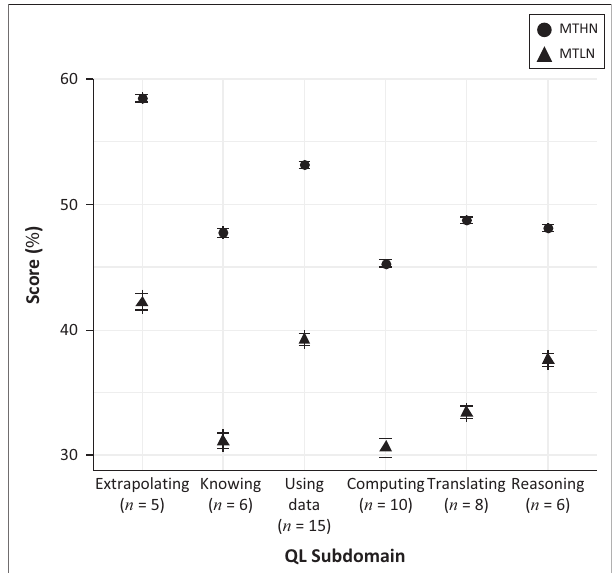
FIGURE 9: Mean scores (and confidence intervals) for each subgroup of items based on the main competency they assess reported separately for the National Senior Certificate Mathematics and Mathematical Literacy candidates.